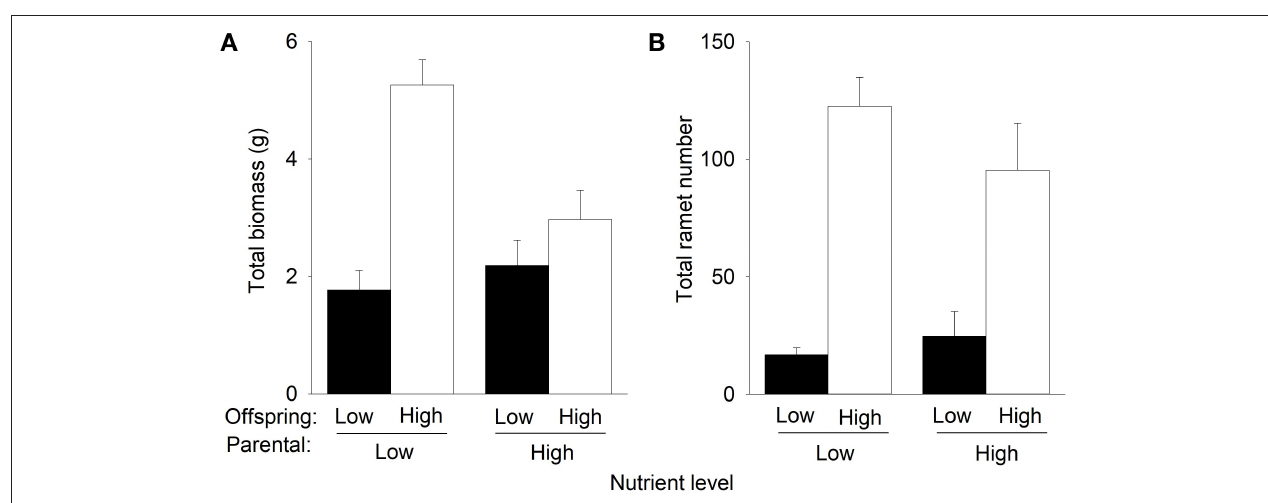
FIGURE 3 | Effects of parental nutrient level and offspring nutrient level on (A) total biomass and (B) total ramet number of Pistia stratiotes produced by the F1 offspring ramets in the second phase of the experiment. Bars show means +